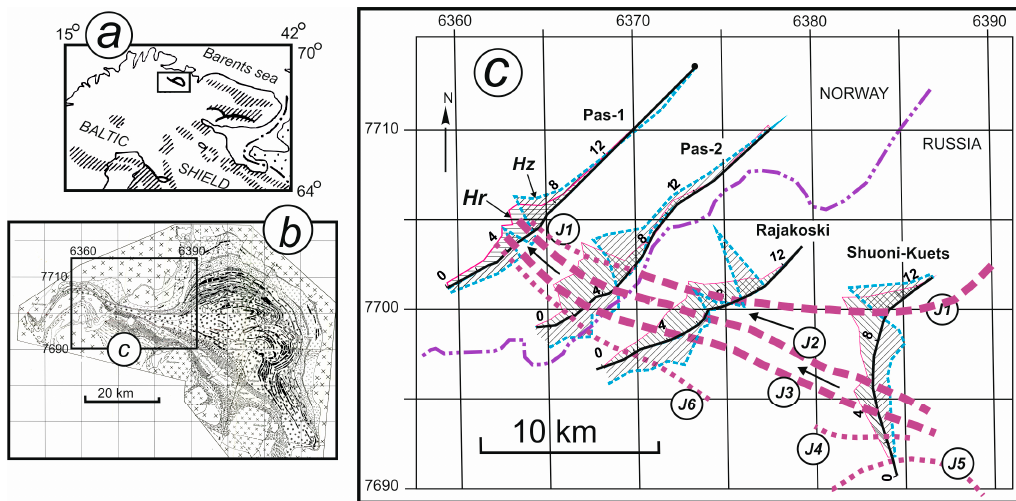
Figure 4. Results of the west Pechenga study in the field of MHD-installation “Khibiny”. ( a ) Thecommon view of the study area; ( b ) geology of Pechenga structure by [17]; ( c ) current-conducting channels (J1–J6) of the west Pechenga and graphs of the anomalous magnetic field of the source “Khibiny”—vertical, Hz and horizontal, Hr. Black arrows show the direction of current flow in conductive channels.